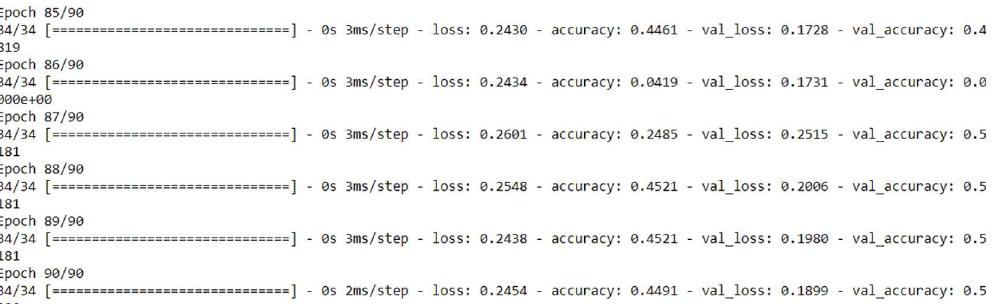
Fig 28. Stability of proposed DNN after 90 epochs and 10